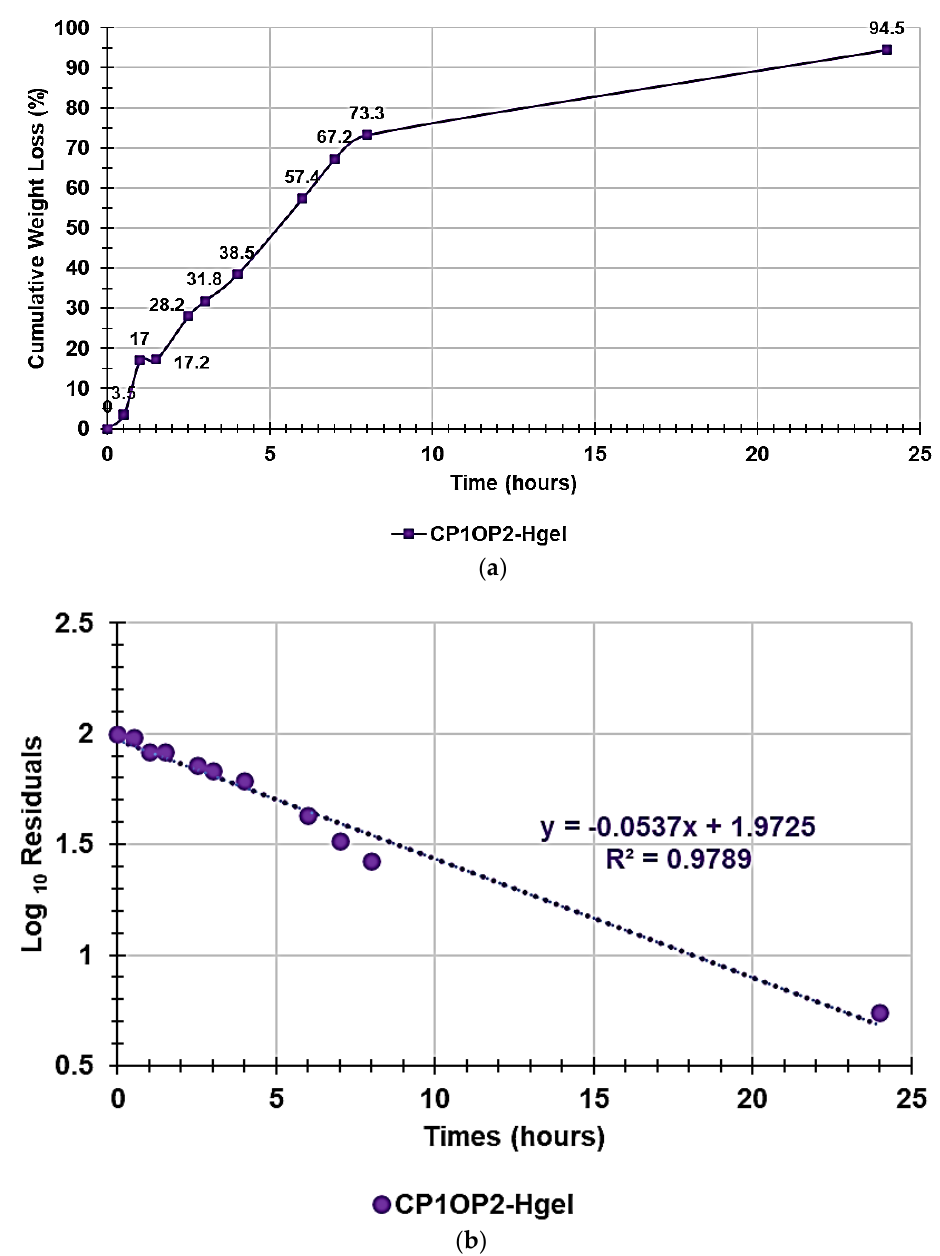
Figure 9. Cumulative weight loss percentage curve of the gel ( a ); first-order kinetic model fitting data of cumulative weight loss curve ( b ).